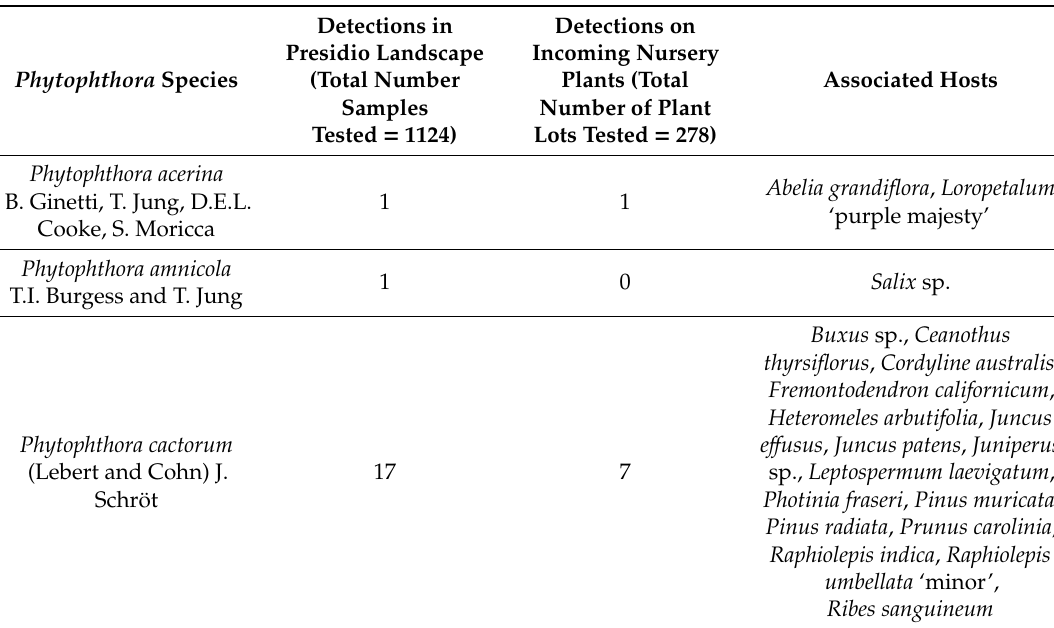
Figure 4. Sampling for Phytophthora at the Presidio. Credit: Courtesy of The Presidio Trust. Table 2. Presidio of San Francisco Phytophthora